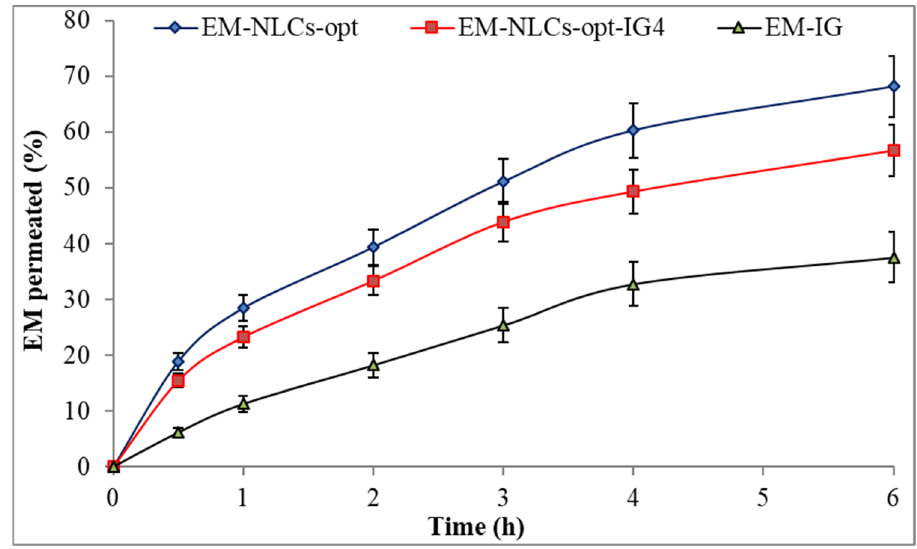
Figure 6. Ex vivo corneal permeation of EM-NLCs-opt, EM-NLCs-opt-IG4 and EM-In situ gel (EM-IG). The study performed in triplicate and data shown as mean ± SD.